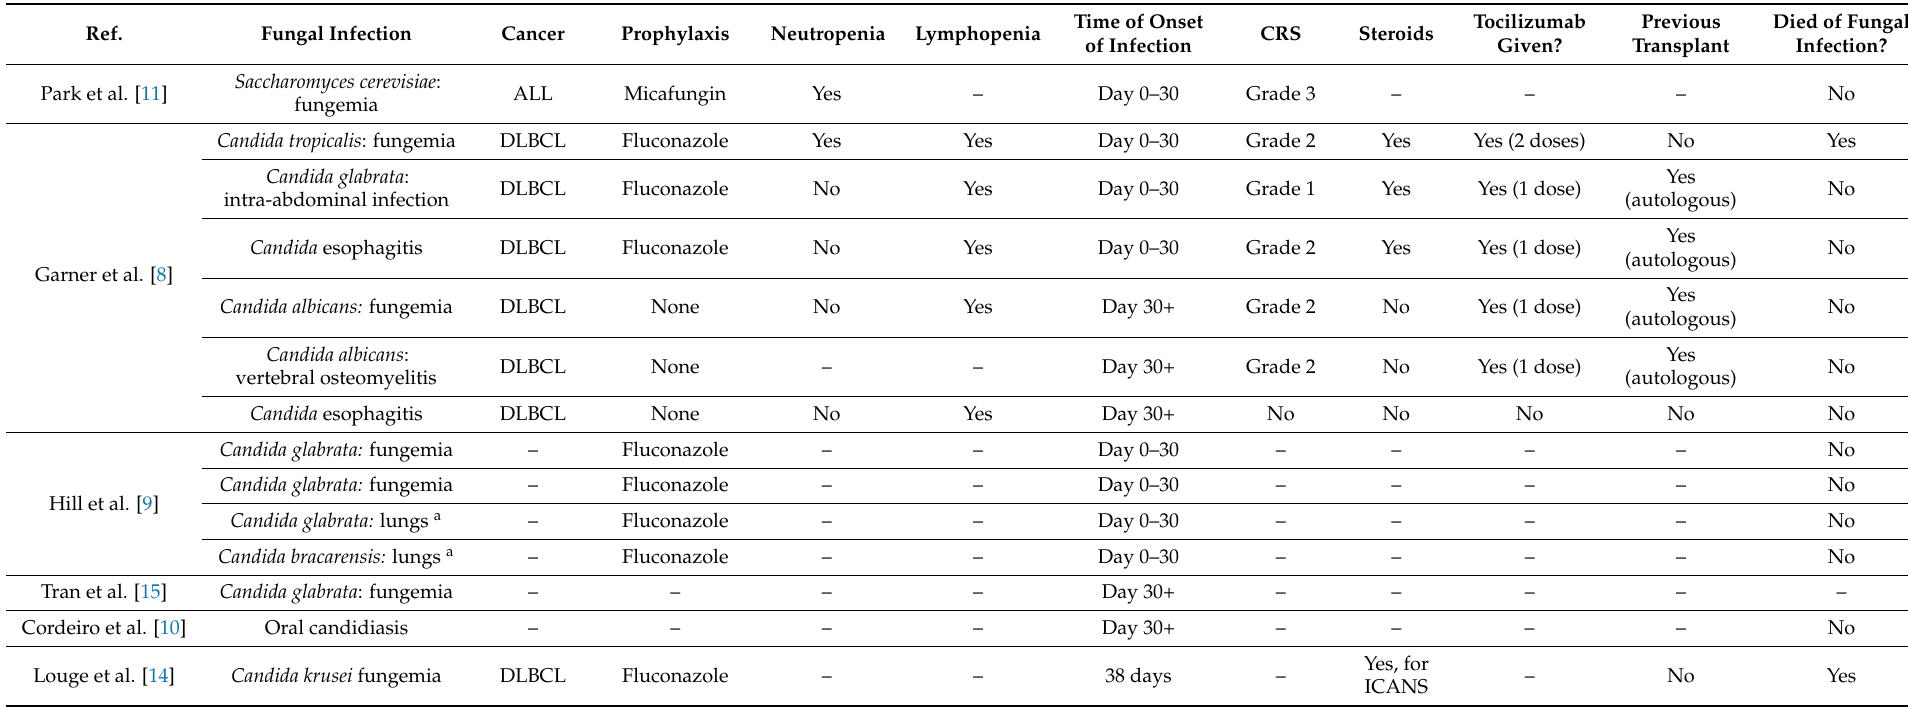
Table 1. Published reports of invasive yeast infections following chimeric antigen receptor-modified T-cell (CAR-T-cell) therapy. Neutropenia defined as absolute neutrophil count <500 cells/ µ L. Lymphopenia defined as absolute lymphocyte count <1000 cells/ µ L. ALL = acute lymphoblastic leukemia; DLBCL = diffuse large B-cell lymphoma; CRS = cytokine release syndrome; ICANS = immune effector cell-associated neurotoxicity syndrome. Dashes indicate that the data were not reported in the studies. a As true invasive Candida spp. respiratory tract infections are rare in patients with hematological malignancies, it is unclear if these isolates represent invasive infections or simply colonization.